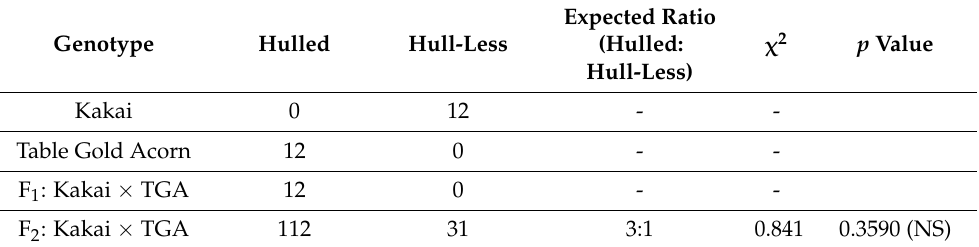
Figure 1. Hull-less and hulled seed phenotype in the parents (Kakai and Table Gold Acorn), the F 1 (SS1135-1), and segregation in the F 2 individuals constituting the hull-less (SS1135-1-11, 20, 38, 42, 65, 68, 114, 167, 185 and 193) and hulled (SS1135-1-3, 30, 36, 43, 55, 125, 127, 128, 150 and 191) bulks used for QTLseq analysis. Table 1. Chi-square test for the inheritance of hull-less seed trait in the F 2 population between Kakai (hull-less) and Table Gold Acorn (TGA, hulled).